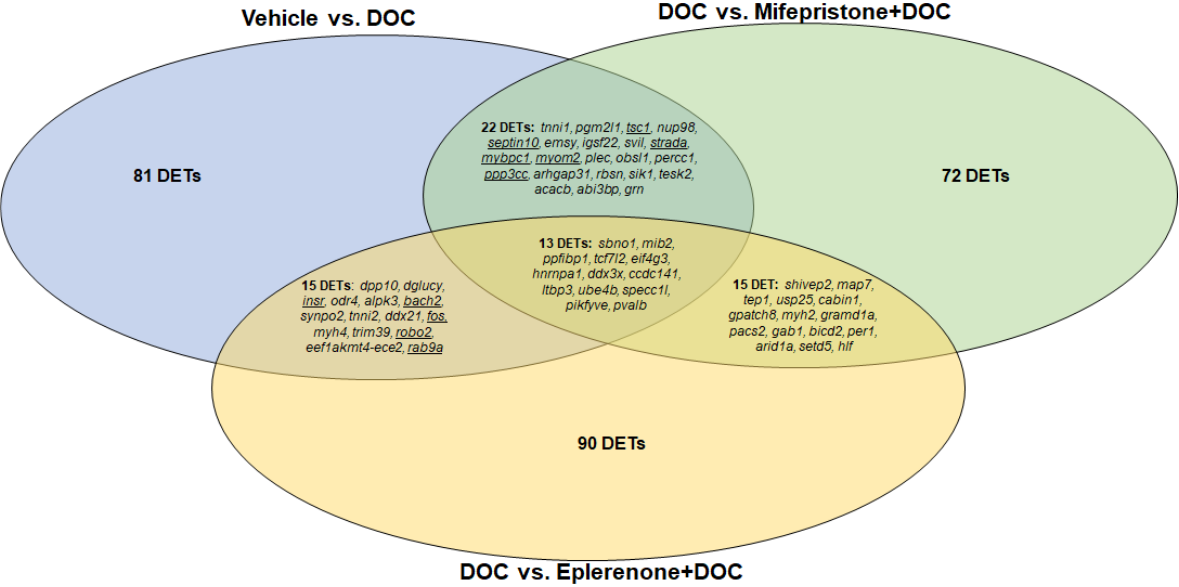
Figure 5. Venn diagram indicating the numbers of differentially expressed transcripts under the vehicle vs. DOC, DOC vs. mifepristone plus DOC, and DOC vs. eplerenone plus DOC treatments. Underlined transcripts were selected for RNA-seq validation by RT-qPCR.